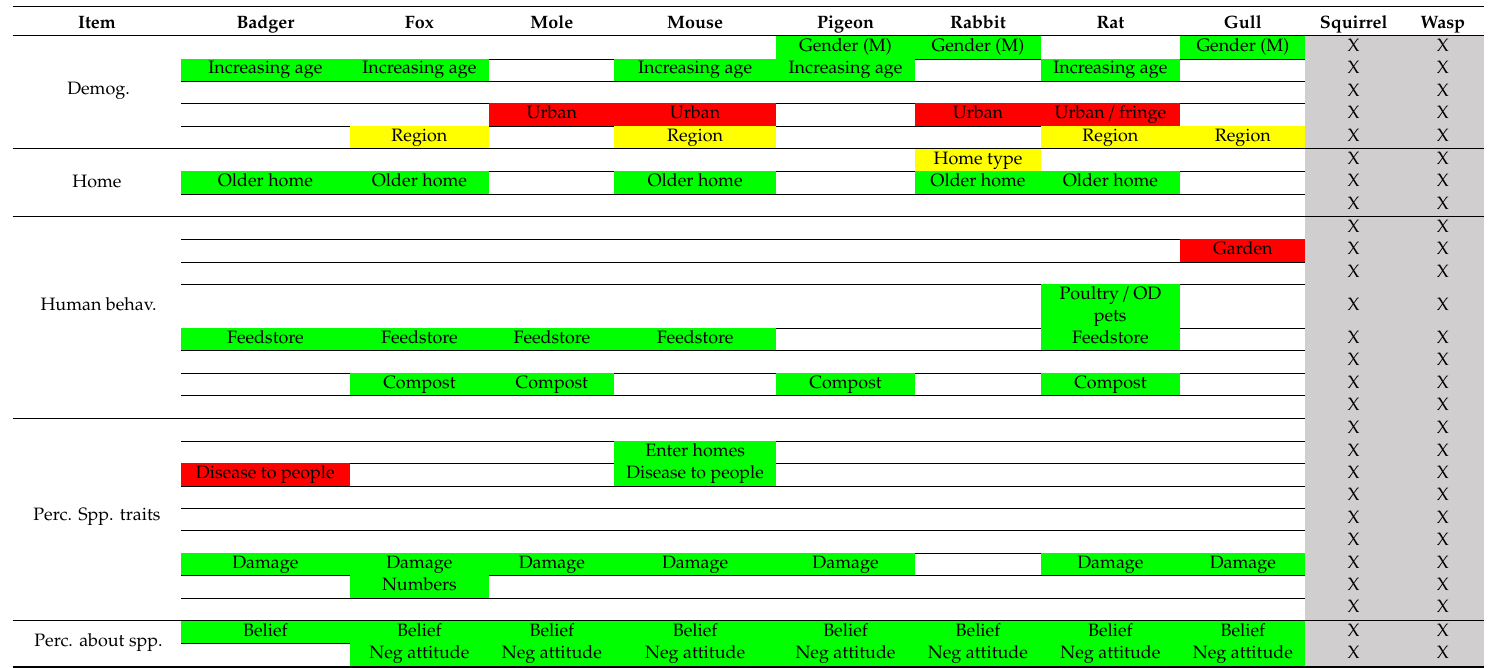
Table 5. Factors associated with people’s personal experience of problems with eight species ( n = 1828). Factors are grouped under: Demog. = ‘Demography’, Home = ‘Home’, Human behav. = ‘Human behaviour’, Perc. spp. traits = ‘Perceived species traits’, and Perc. about spp. = ‘Perceptions about species’. Factors shown in red were associated with a lower likelihood of experiencing problems, those shown in green were associated with a greater likelihood, and those shown in yellow were associated with a more complex e ff ect. See the list of abbreviations for factors in Supplementary Materials Table